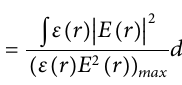
Frontiers in Materials |